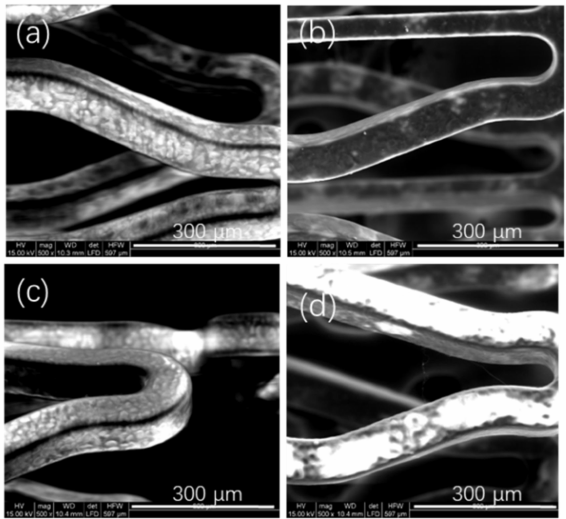
Figure 5. Morphologies of coating surfaces made with different Rates of solution flow of P34HB-1. ( a ) 0.01 mL/min; ( b ) 0.02 mL/min; ( c ) 0.08 mL/min; ( d ) 0.09